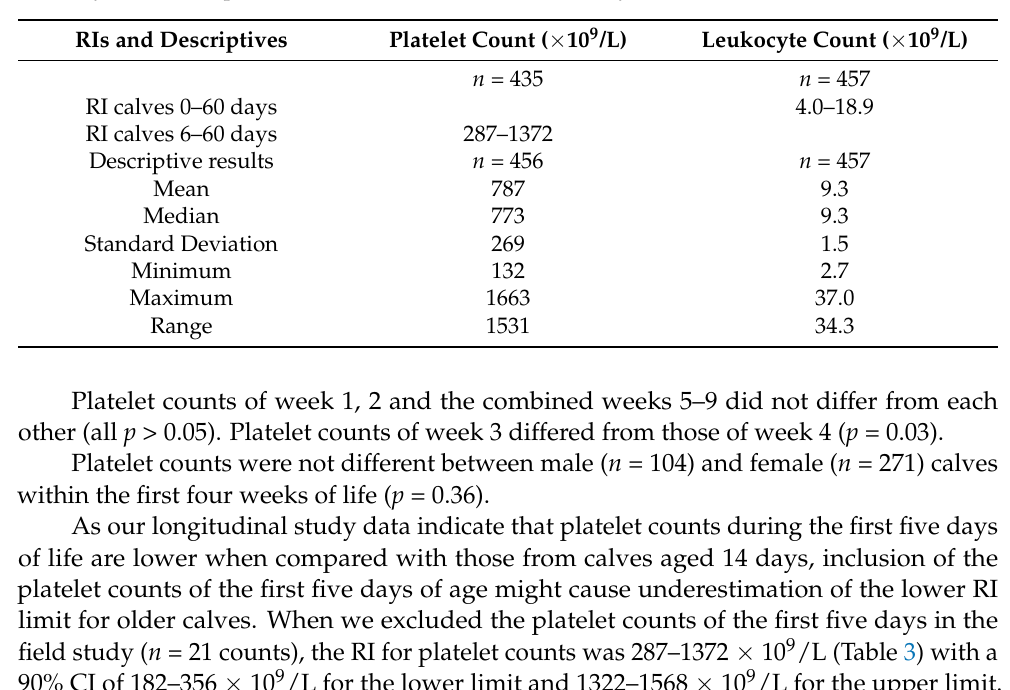
Table 3. Reference intervals (RIs) of platelet and leukocyte counts of calves 0–60 days, calves 6–60 days and descriptive results derived from the field study. All values shown in × 10 9